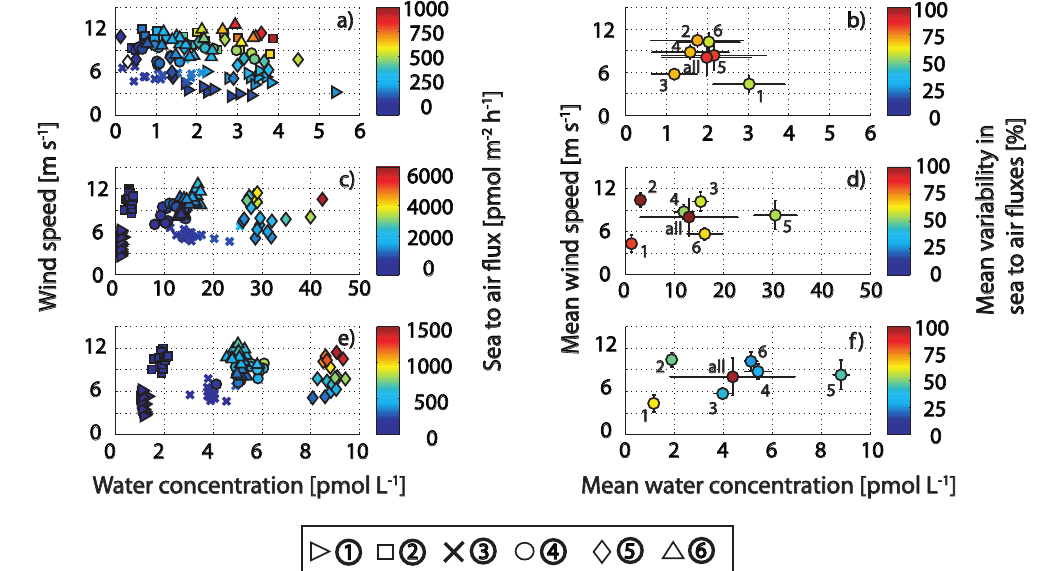
Fig. 8. Left side – wind speed versus CH 3 I (a) , CHBr 3 (c) and CH 2 Br 2 (e) water concentrations. Symbols are filled according to their sea- to-air flux (see color bars). Right side – mean wind speed versus mean CH 3 I (b) , CHBr 3 (d) and CH 2 Br 2 (f) water concentrations with their standard deviations which is expressed in error bars (horizontal for water concentrations and vertical for wind speed) for each diel station (S1–S6) and for all stations together. Symbols are filled with the relative standard deviations of the sea-to-air fluxes (see color bars).